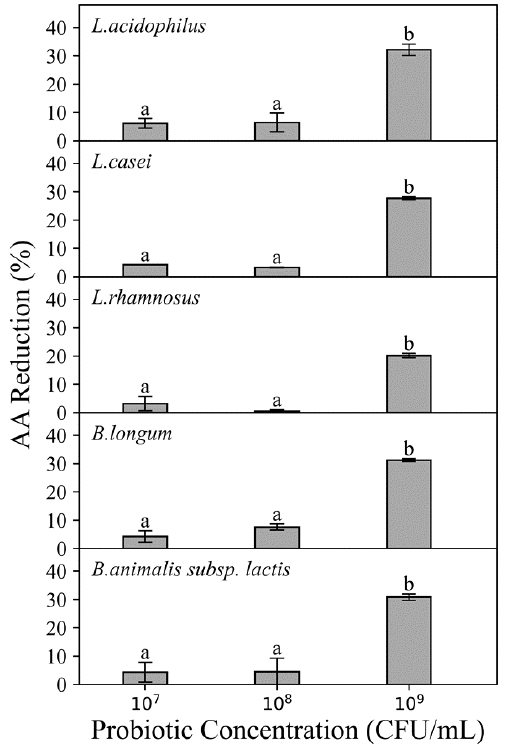
Figure 1. The acrylamide (AA) reduction ability of five strains of probiotic bacteria with concentra- tions at 10 9 CFU/mL, 10 8 CFU/mL and 10 7 CFU/mL. Exposed to 750 ng/mL AA solution. Incubated at 37 ◦ C for 4 h at pH 6.5–7.0. Expressed as AA reduction percentage. Different characters in same panel indicate significant differences, whereas same character means not.